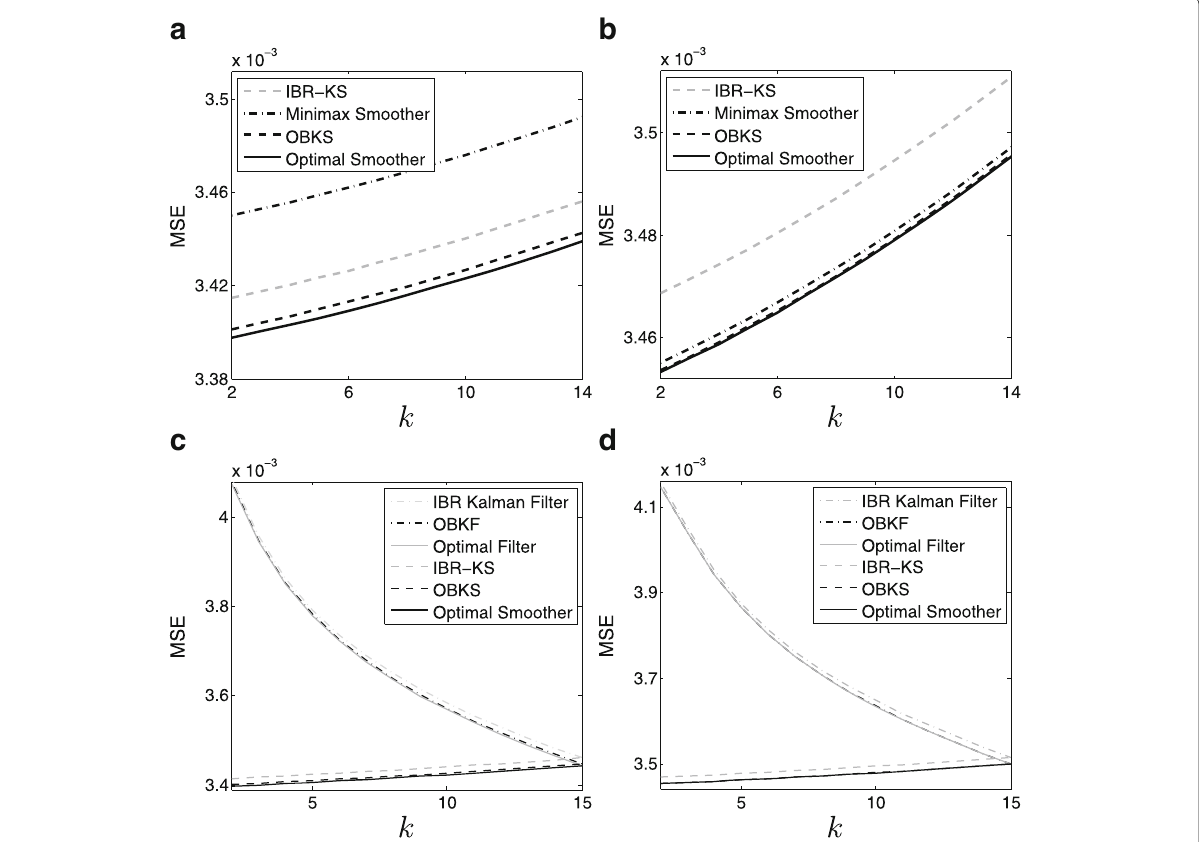
Fig. 12 Performance comparison relative to specific state-space models. a MSE of different smoothers for θ = 1.5. b MSE of different smoothers for θ = 5. c MSE of different smoothers and filters for θ = 1.5. d MSE of different smoothers and filters for θ =